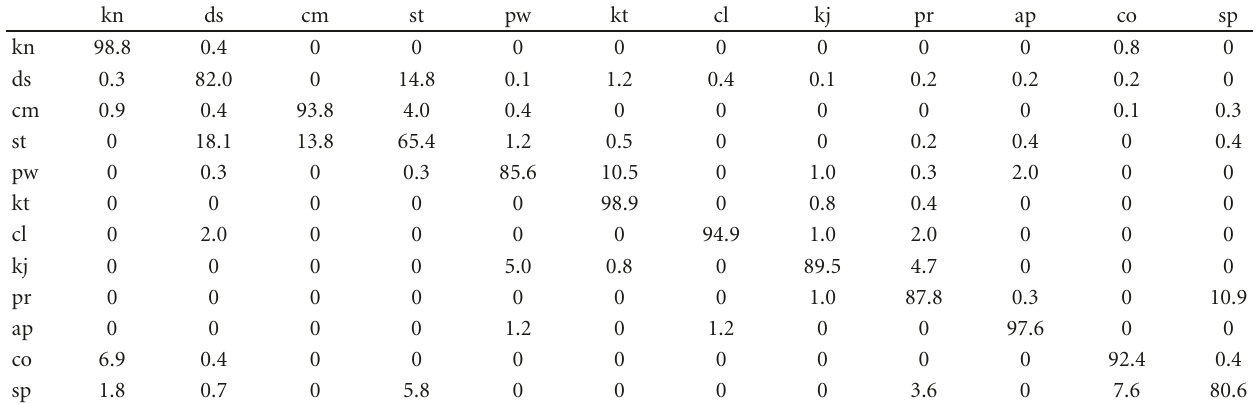
Table 3: Confusion matrix corresponding to the baseline system (the results are presented in %).